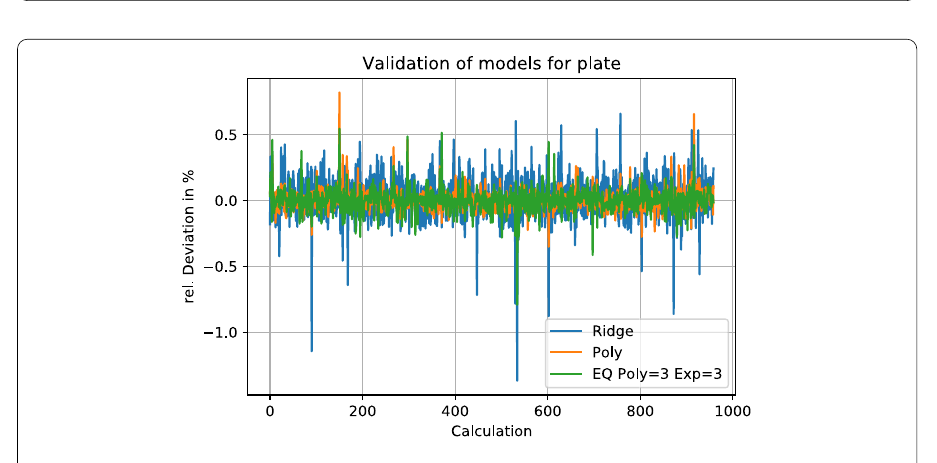
Fig. 30 Validation of plate against new data set